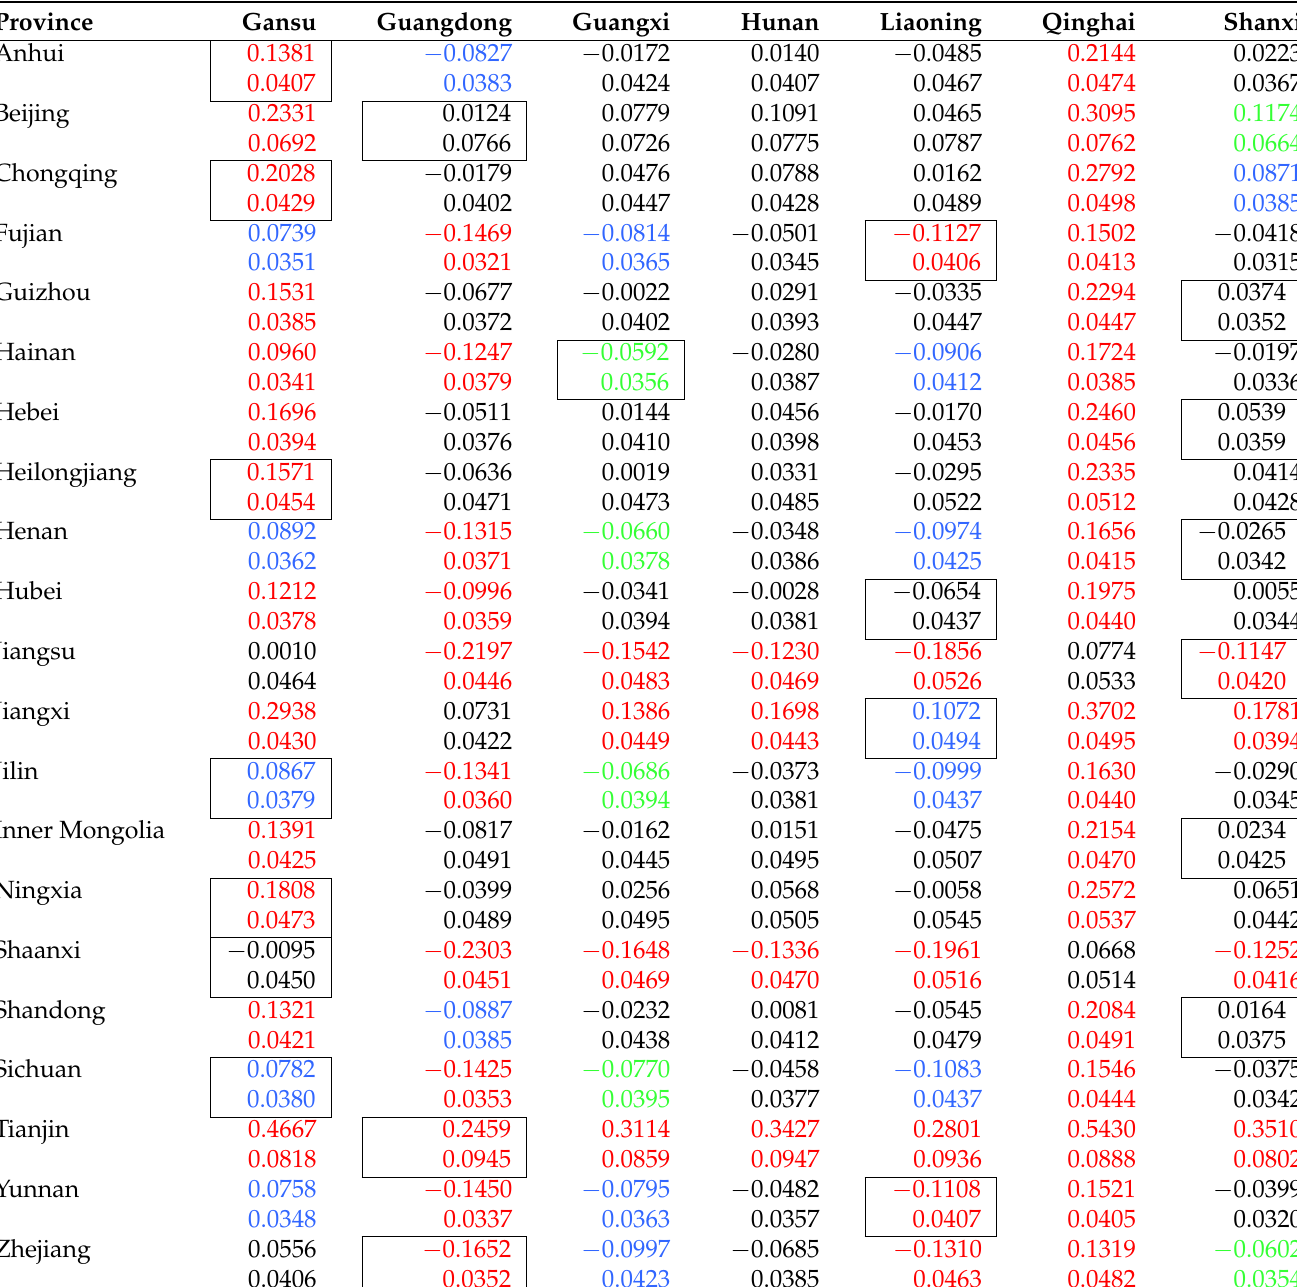
Table 8. ATET estimates (with corresponding standard error listed beneath) for each treated (row) vs. each control (column) province (for families in rural areas) for those who own their own home (note that Shanghai does not have a rural area and is hence not included in the table): Significance of point estimates at the arbitrary 1, 5, and 10 percent levels are colored red, blue, and green, respectively—a box is given for the control province most closely aligned with the treatment province in terms of absolute minimum